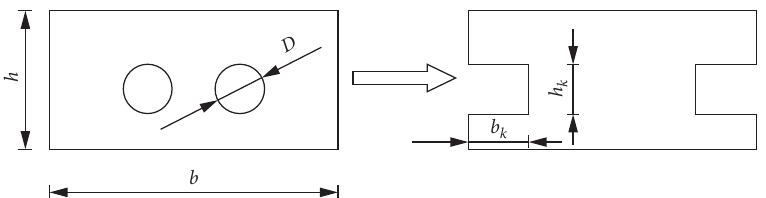
Figure 19: Reduced calculation model.